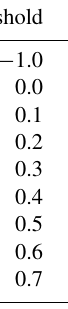
Table 3. Number of TGs at which trends are estimated from differ- enced ALT–TG time series. The “ − 1 . 0” indicates that no correlation threshold is